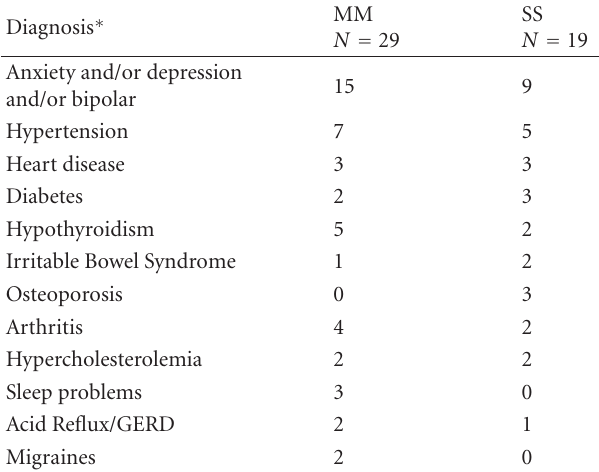
Table 5: Case-control series of individuals with COPD and asthma in which at least one individual with the PiSS genotype has been